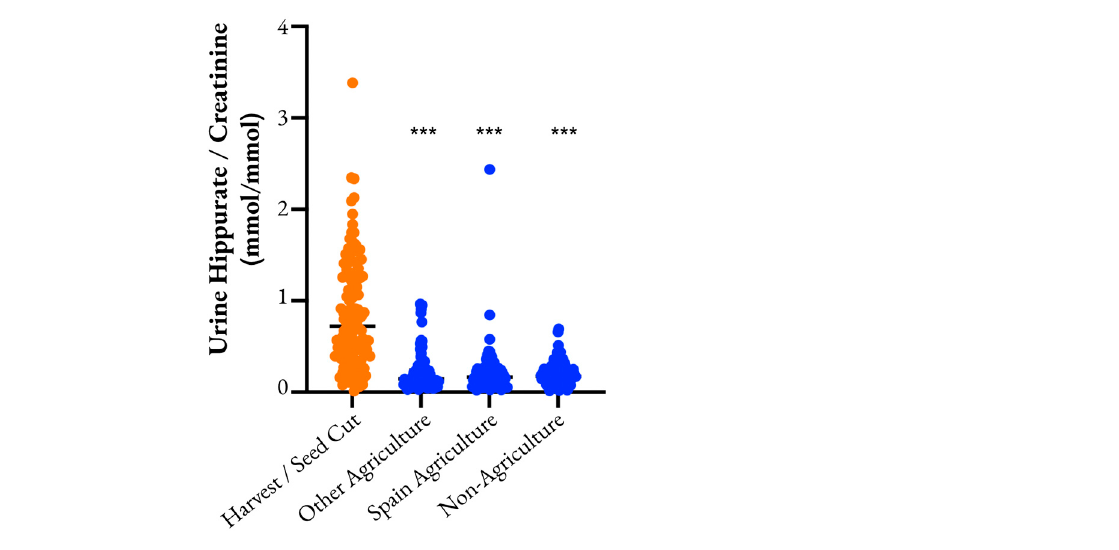
Figure 4. Differential metabolic features of urine between groups pooled by risk factor using partial least squares discriminant analysis (PLS-DA). Two-dimensional visualization of separation of groups by PLS-DA is shown in ( a ) individuals living in Nicaragua (Nica) vs. Spain, ( b ) individuals working in high- vs. low-intensity manual labor jobs, and ( c ) individuals working in agriculture (Ag) vs. not in agriculture (NotAg). Important features by variable importance in prognosis (VIP) score in PLS-DA are shown for ( d ) Nicaragua vs. Spain, ( e ) high- vs. low-intensity labor, and ( f ) agriculture vs. not in agriculture. Permutation test validation based on separation distance is shown for PLS-DA models for ( g ) Nicaragua vs. Spain, ( h ) high- vs. low-intensity labor, and ( i ) agriculture vs. not in agriculture. 1MG, 1, methylguanidine; GAA, guanidinoacetic acid; 2FG, 2-furoylglycine; MMA, methylmalonic acid; PAA, phenylacetic acid; MNA, 1-methylnicotinamide; 2oxoIVA, 2-ox- oisovaleric acid; NAG, N-acetylglutamate; 4-HHA, 4-hydroxyhippuric acid; 1MG, 1-methylguani- dine; 3MG, 3-methylglutaconic acid. 3.2. Hypothesis-Based Explorations Levels of the metabolites NAD+, Trp, KynA, Nam, and MNA compared among groups are shown in Table 3. Comparison between the CS and OW and SW and NW groups reveals higher levels of NAD+ and KynA, although differences were not signifi- cant across all pairwise comparisons.